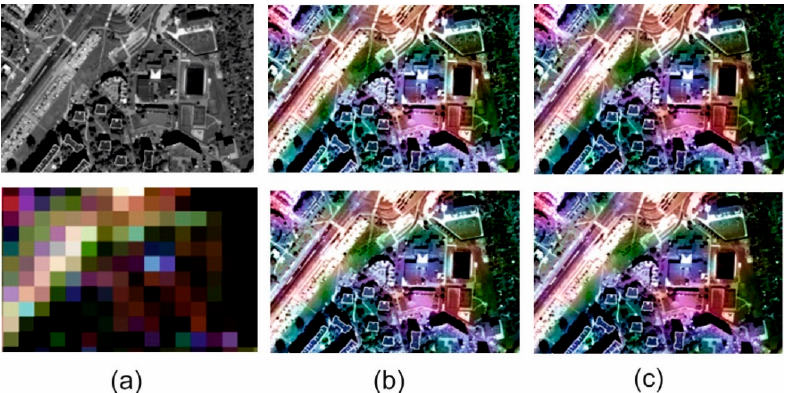
Figure 10. ( a ) Original panchromatic WorldView-2 image and multispectral Landsat 8 OLI image. ( b ) Results of data fusion using the classical approach (above) and modified approach (below) after GIHS fusion. ( c ) Results of data fusion using the classical approach (above) and modified approach (below) after GIHS-BT fusion for urbanized area